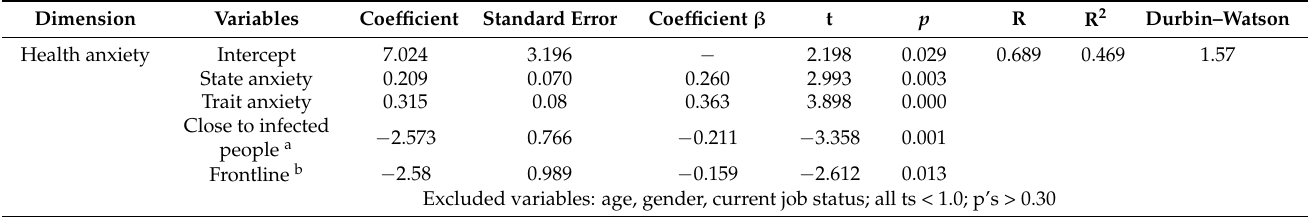
Table 5. Multiple linear regression with health anxiety as outcome variable, and state anxiety, trait anxiety, age, gender, working frontline, current job status, and being in contact with people infected with COVID-19 as predictors.